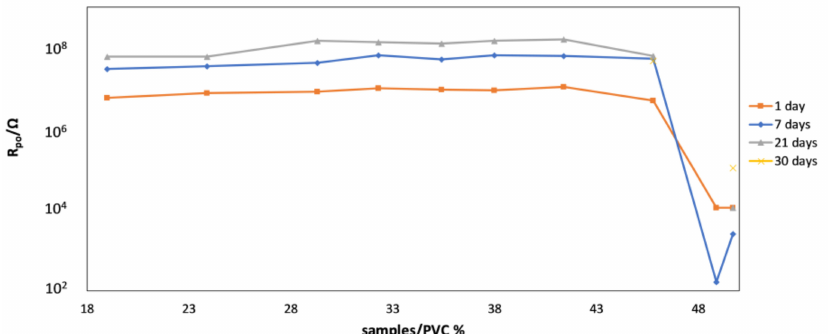
Figure 8. Pore resistance vs. di ff erent PVC of the representative samples WB talc coatings serie. Note that among the samples corresponding to 30 days, only two samples exhibited pore resistivity (see yellow symbols).